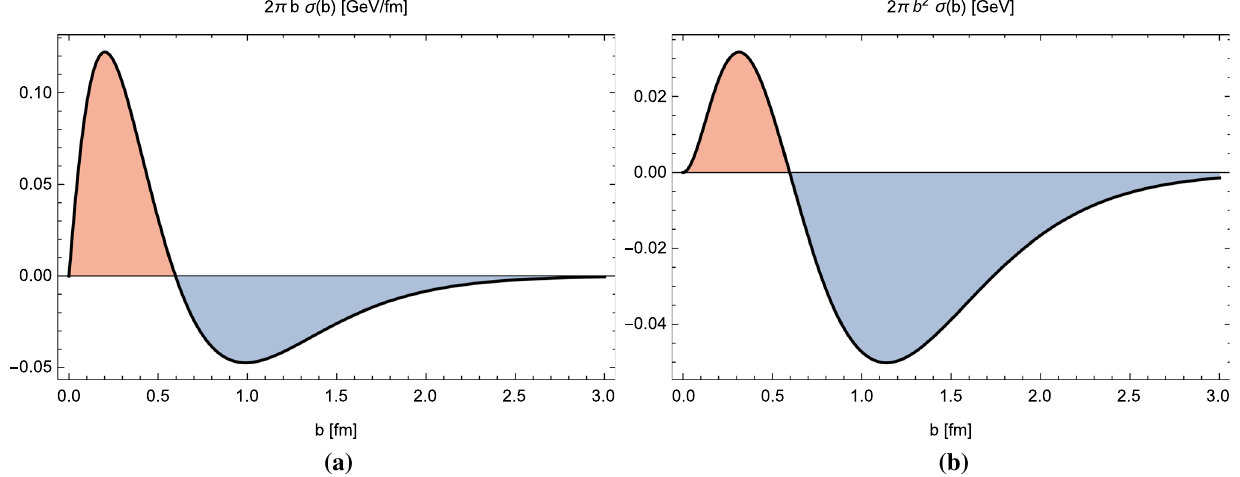
Fig. 20 Illustration of the hydrostatic equilibrium in the elastic frame. a Integrand of the two-dimensional von Laue condition (133) and b the same integrand multiplied by